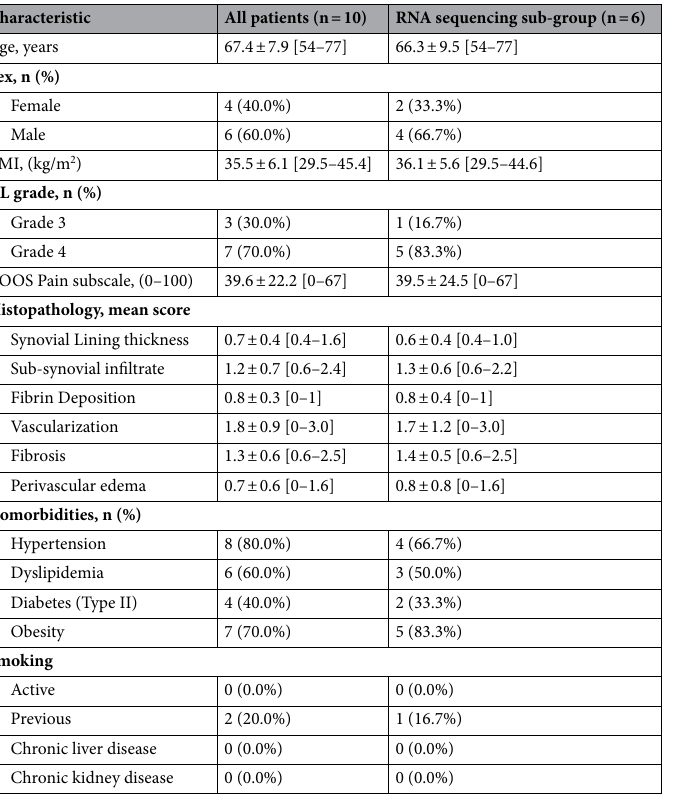
Table 1. Patient demographics, clinical characteristics and synovial histopathology. Mean ± SD (minimum, maximum) or n (%). BMI, body mass index; KL, Kellgren-Lawrence grade; KOOS, Knee Injury and Osteoarthritis Outcome